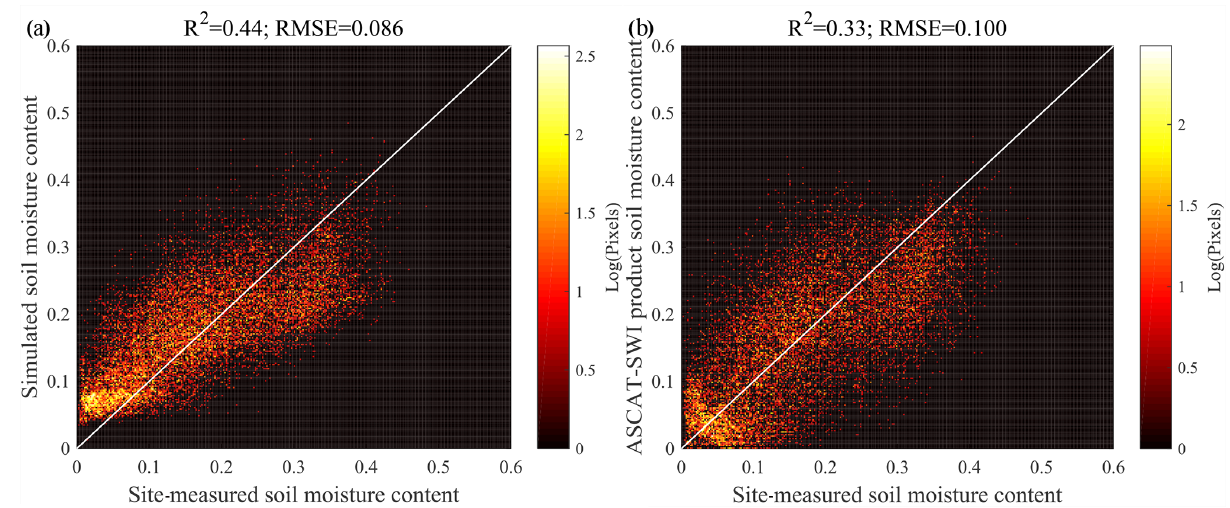
Figure 7. Overall data accuracy comparison between RSSSM and the ASCAT-SWI data product. The scatterplot is between (a) RSSSM or (b) ASCAT-SWI soil moisture and the site-measured values during 2007–2018. The unit of all plots is the density of points on a logarithmic scale.